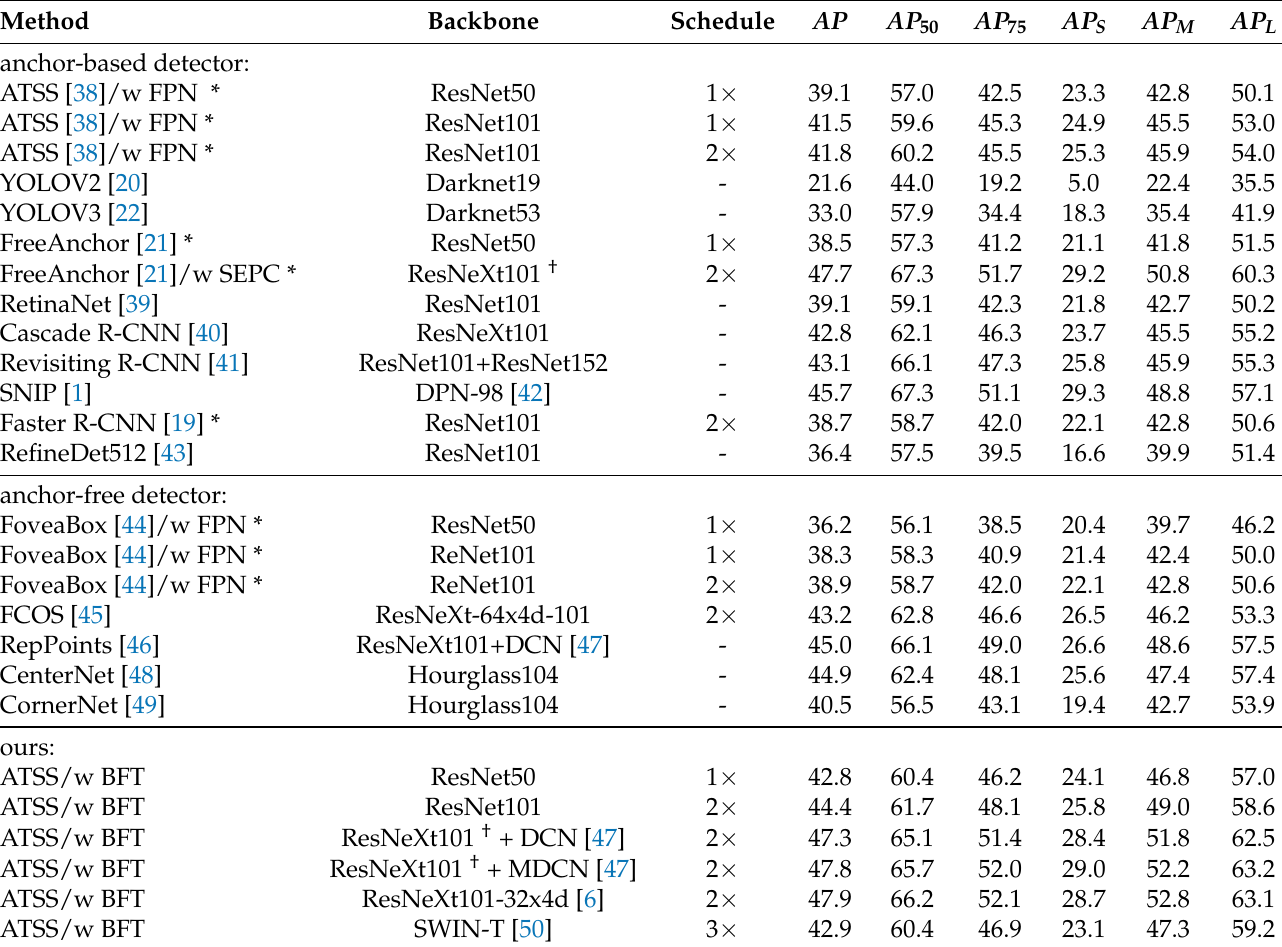
Table 2. Performance comparison with the state-of-the-art (SOTA) results on MS-COCO. Symbol “*” means our reimplemented results, and mark “ † ” means